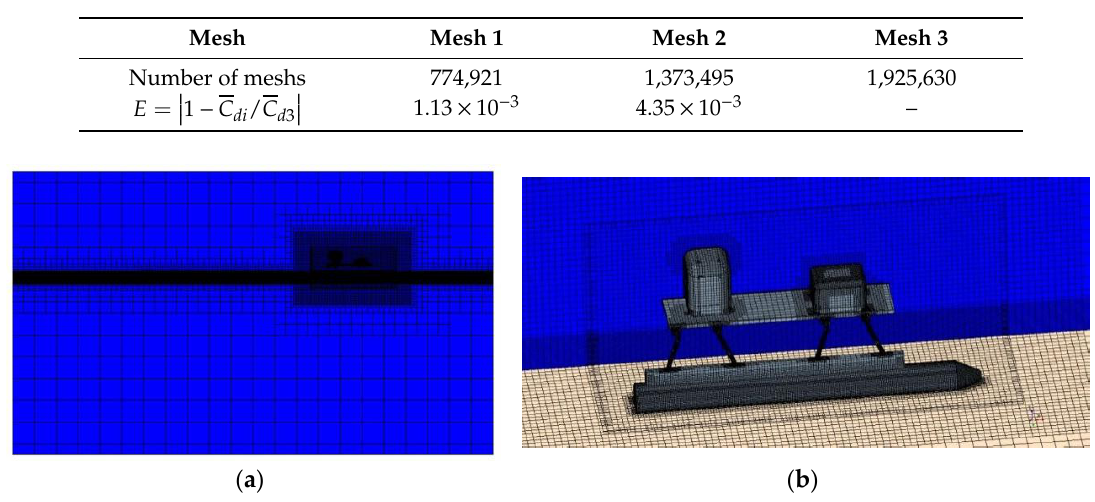
( b ) Figure 4. S57 Environmental Modeling Map ( a ) Study Area of S57 Electronic Chart . ( b ) Regional Grid Marine Environment Map with a resolution of 25 m × 25 m. In the picture, the white meshes represent the feasible region, while the black meshes are a barrier. In vector electronic navigation charts, spatial objects, such as land area, island reef, and navigation aids, are stored and expressed in the form of point, line and area features. In this paper, feasible space [25] is obtained by selecting objects which could risk on navigation. Obstacle region